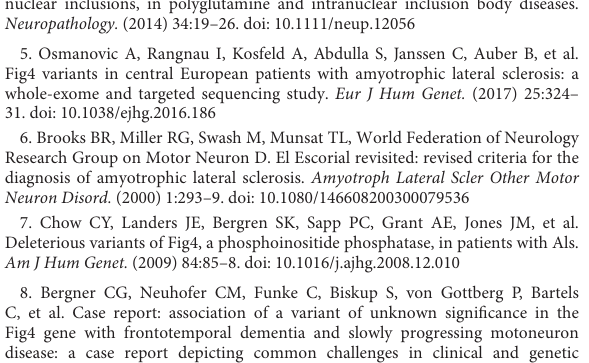
Fig4 gene in familial epilepsy with polymicrogyria. Neurology. (2014) 82:1068–75. doi: